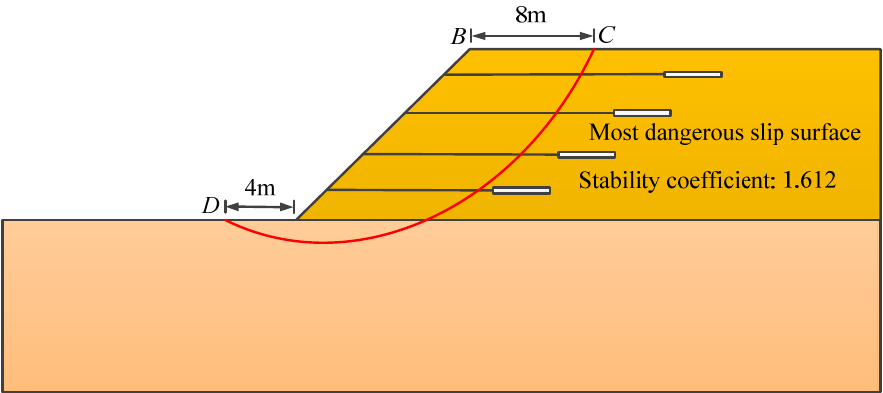
Figure 22. Example 2 calculation results of the stability of this method.